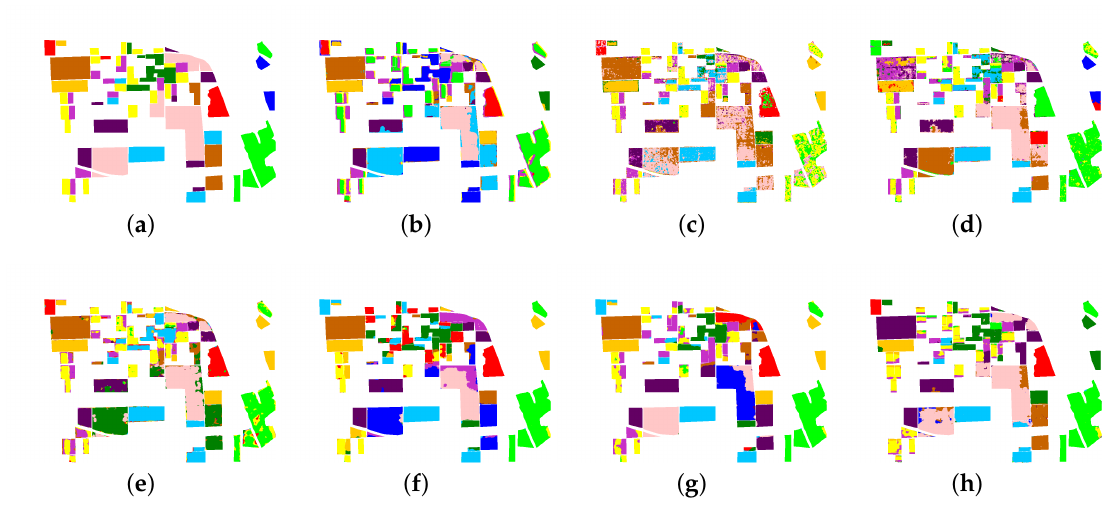
Figure 11. Classification results of AIRSAR Flevoland dataset. ( a ) Ground truth map; ( b ) K-means;